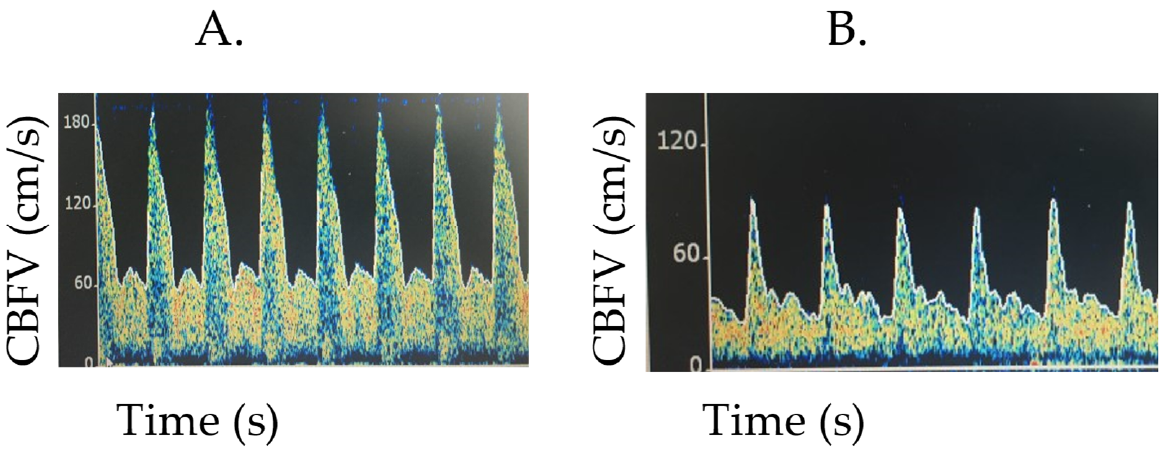
Figure 3. Examples of TCDs with concern for elevated intracranial pressure. ( A ). The child’s Vs is maintained with a reduction in Vd, leading to a subsequent increase in the PI. Flow velocities (cm/s), Vs 167, Vm 76.6, Vd 56.2, PI 1.43. ( B ). In this image, Vd is more reduced than Vs, also with an increase in PI. Flow velocities (cm/s): Vs 90.1, Vm 43.1, Vd 26.9, PI 1.45.